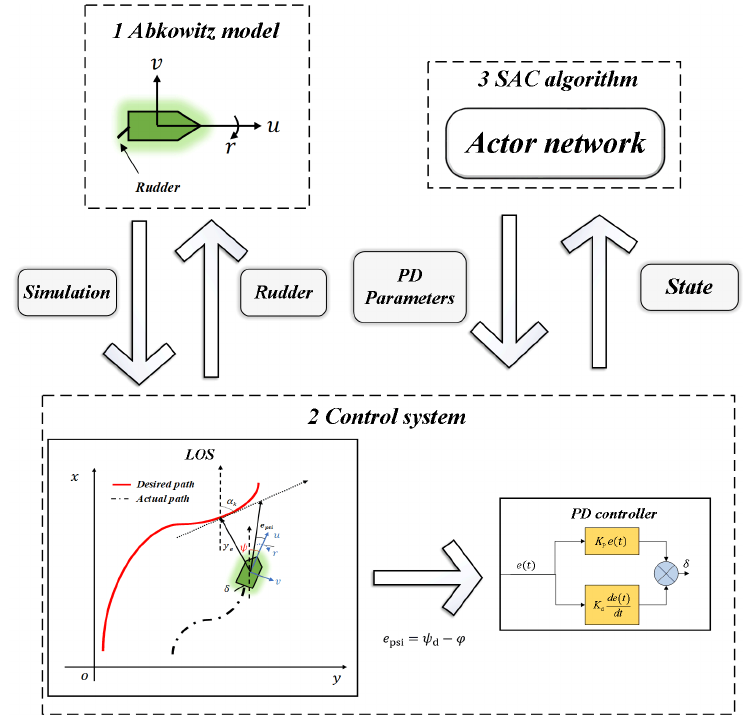
Figure 1. The overall flow diagram for the proposed method.